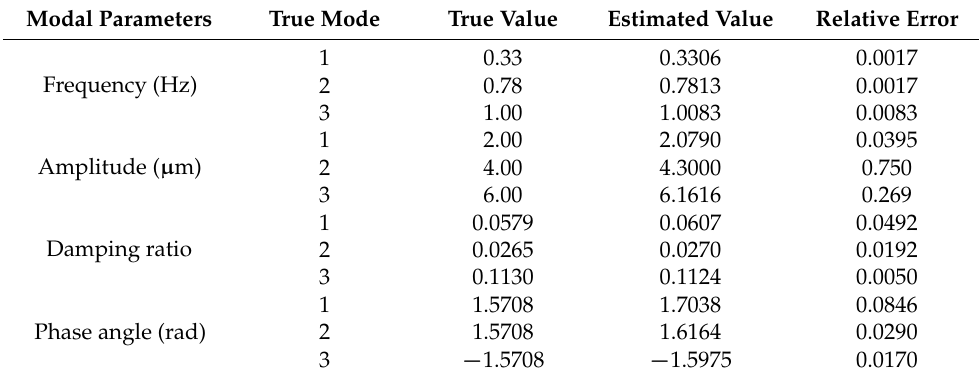
Table 9. Comparison of estimated modal parameters of SMPI with true modal parameters.